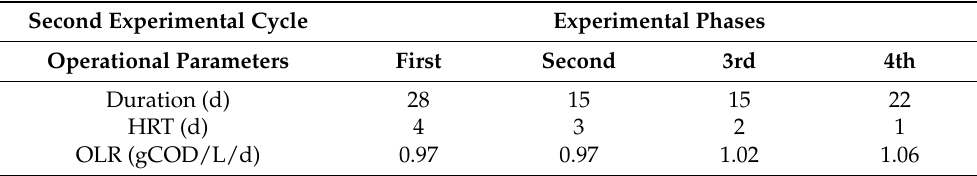
Table 2. Operational parameters imposed during the second experimental cycle. Second Experimental